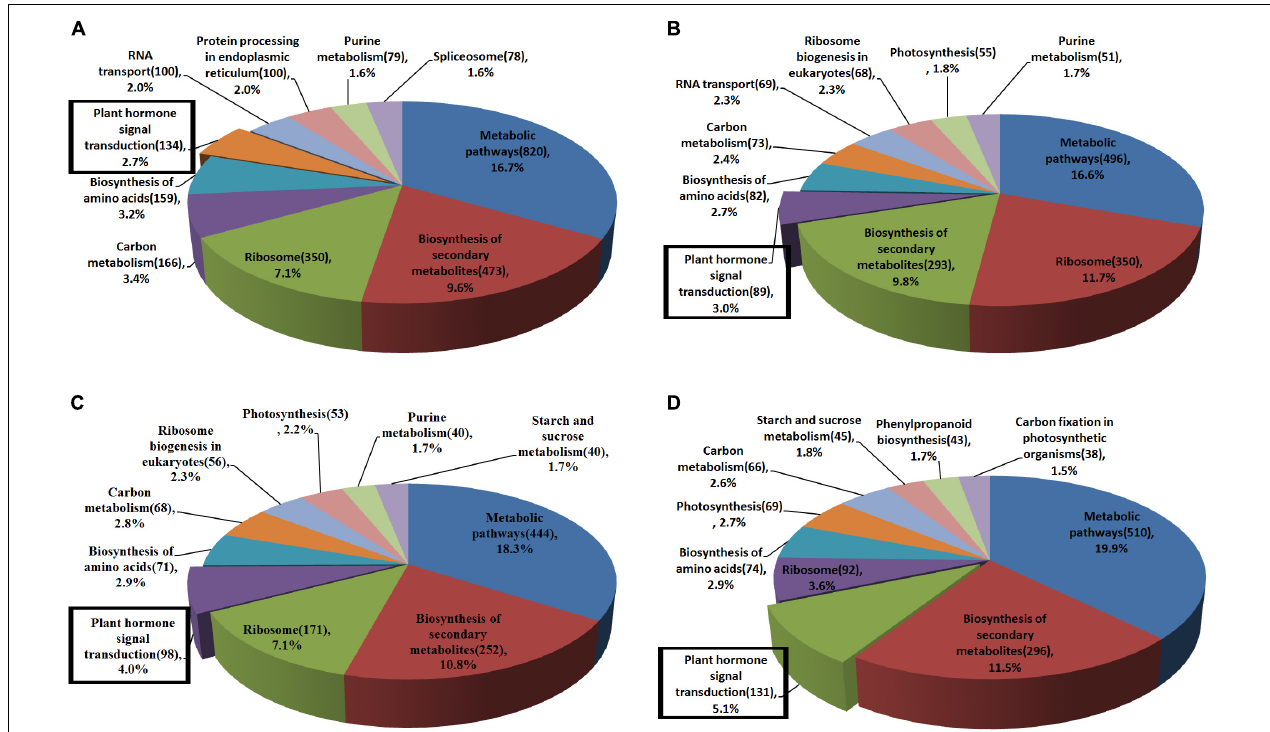
FIGURE 3 | The main KEGG pathways of DEGs in fg-1 compared with wild type. Different colors represent the pathway names. The number of genes involved in each pathway is labeled in parentheses. Pathways in the rectangular boxes are involved in plant hormone signal transduction. (A–D) represent the main KEGG pathways of DEGs in sections a–d of the fg-1 leaf compared with the wild type, respectively.